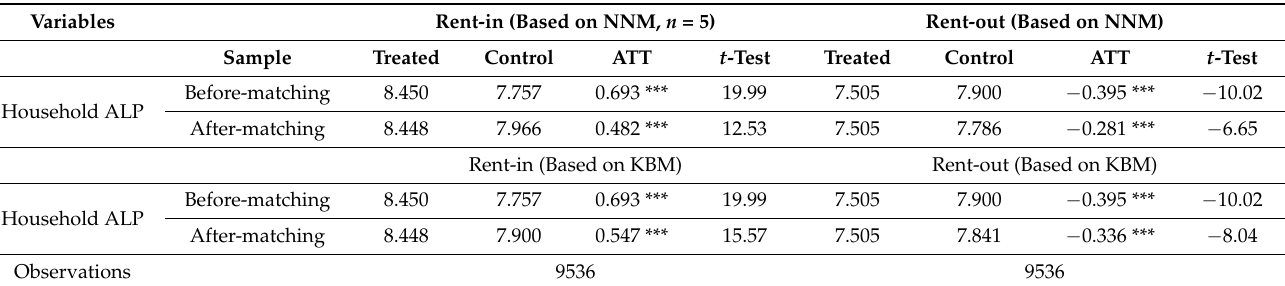
Table 3. Logit model result of factors affecting land rental